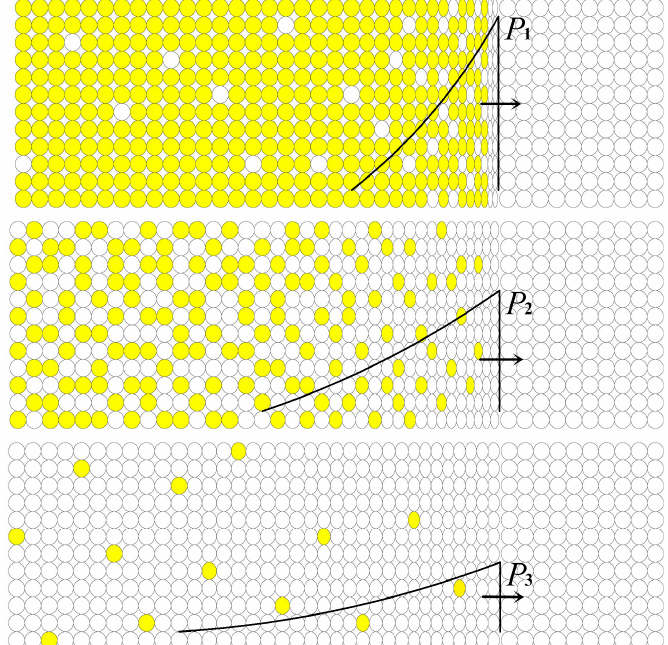
Figure 8. Schematic illustration of reaction propagation under explosive loading. The black profile represents the pulse shock wave propagating in the energetic materials. The arrow shows the propagation direction. The use of color within the idealized microstructure symbolizes the chemical reaction.